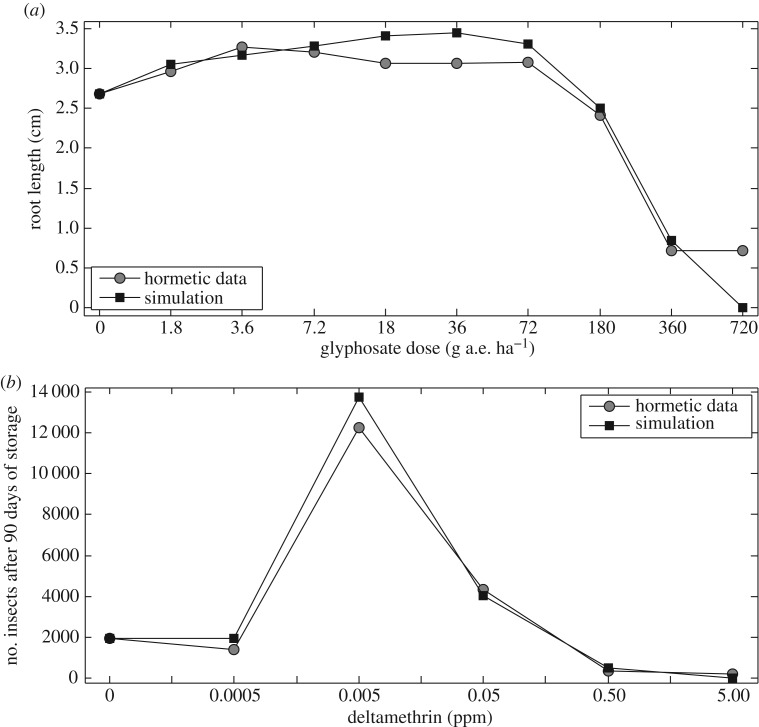
Hormetic data fitting. (a) Hormetic effect of glyphosate on growth of chick pea after 21 days spraying, measured by root length. The estimated parameter values are r=4, θ=0.53, ρ=0.09. (b) Hormetic effect of deltamethrin on predicted population size of maize weevil. The estimated parameter values are r=4.999, θ=0.1066, ρ=8.08.